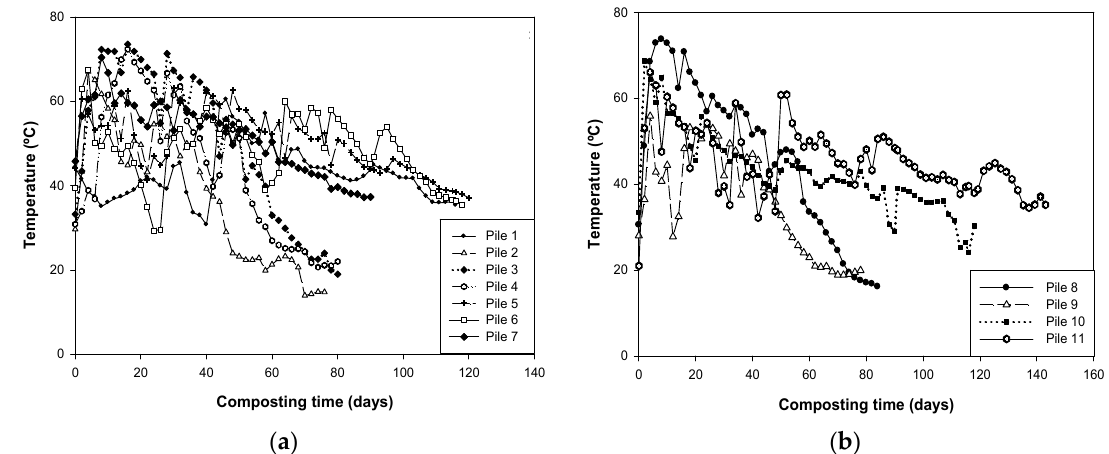
Figure 1. ( a ) Temperature profiles in the composting mixtures derived from sewage sludge (MS); ( b ) Temperature profiles in the composting mixtures derived from agri-food sludge (AS).